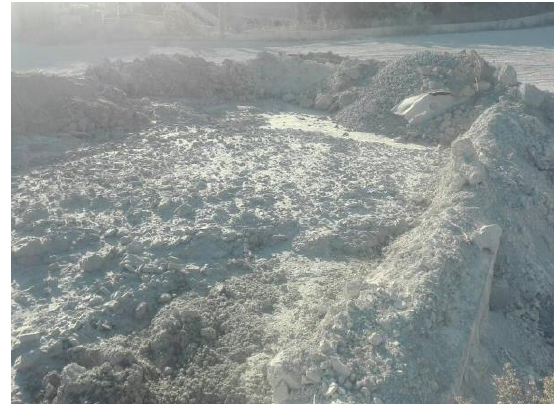
Figure 3. Stockpiled cement sludge fines (CSF) within the ready-mixed concrete (RMC) plant.